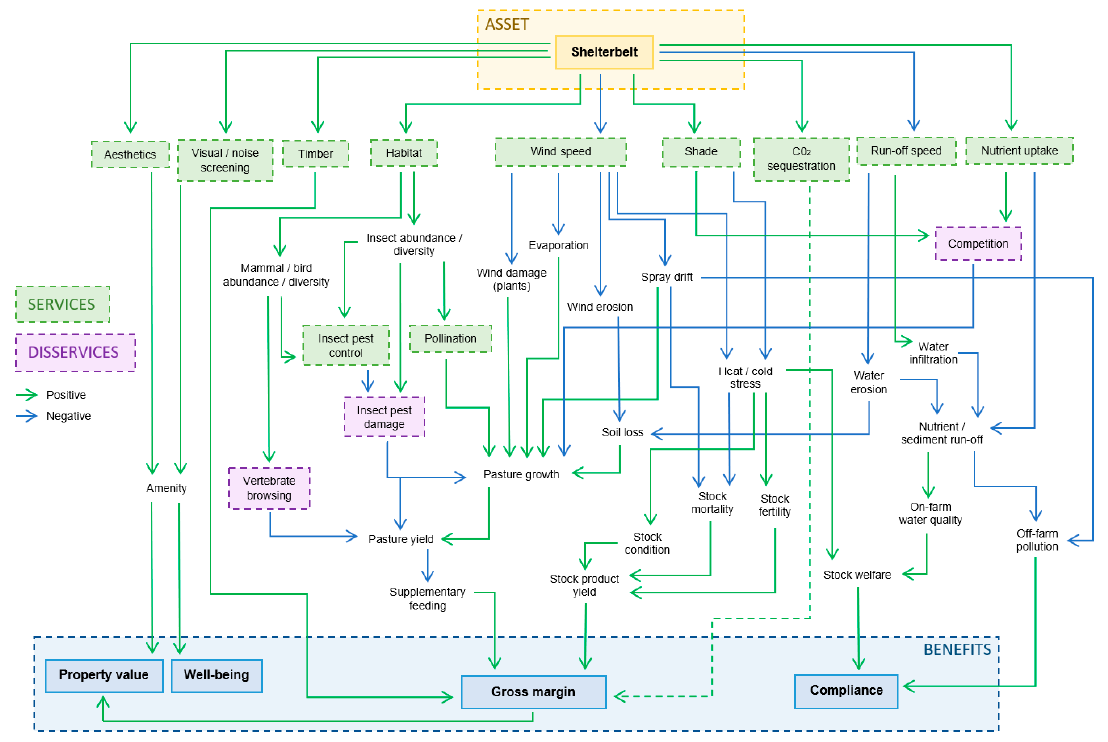
Figure 3. Conceptual model for ecosystem services and associated benefits provided by one common type of agroforestry asset (shelterbelt) in a temperate pasture/livestock system. Blue lines represent negative effects (i.e., reduction), and green lines positive effects.